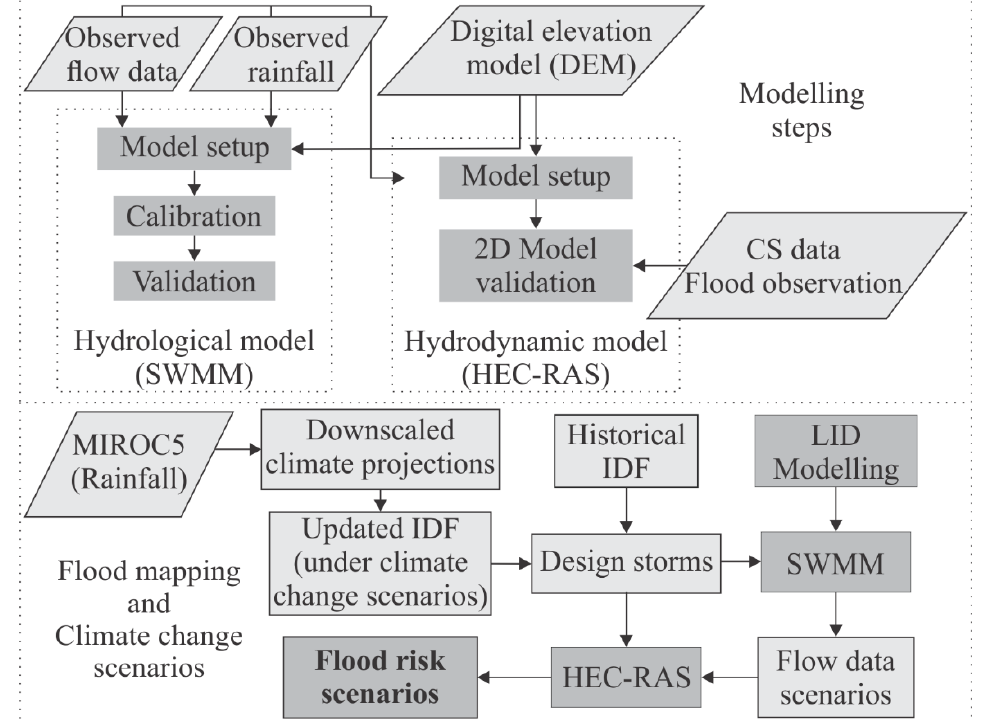
Figure 2. Methodological activity diagram. The light gray rectangles represent the input data (primary and secondary) for each activity and the dark gray rectangles represent the main methodological steps.